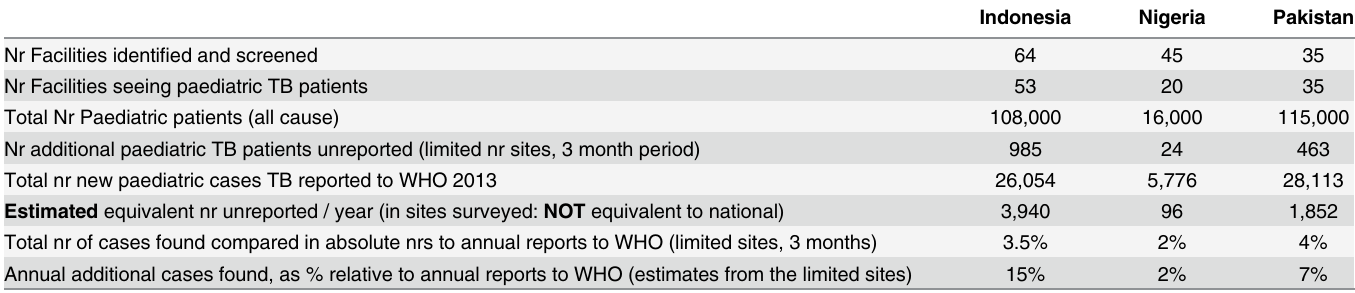
Table 2. Overview of findings: number of children seen in non-NTP facilities, diagnosed with suspect or confirmed tuberculosis, but not reported to NTP (by country, (May – July